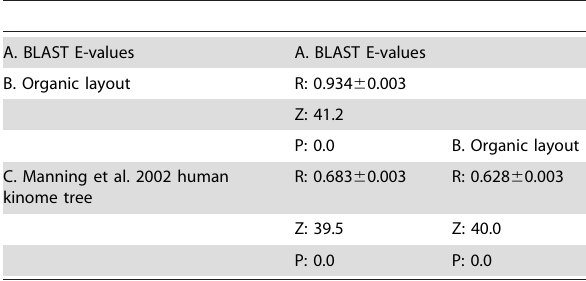
Table 2. Comparison of network and phylogenetic tree distances between 419 kinase